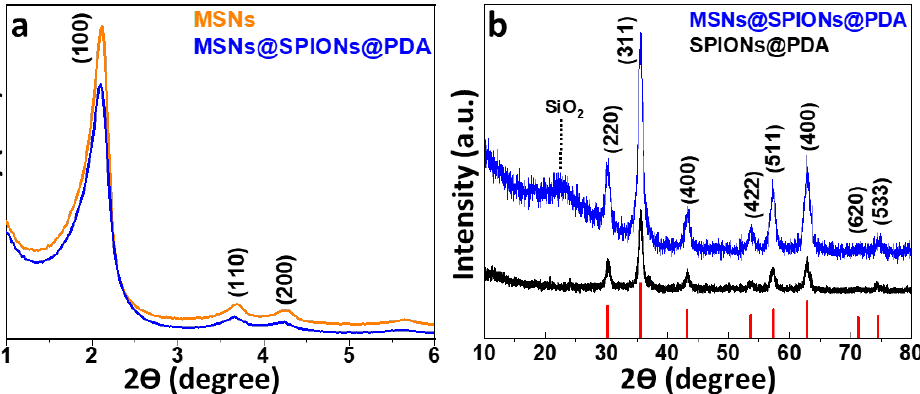
Figure 4. ( a ) Low- and ( b ) wide-angle XRD patterns of MSNs (orange pattern), SPIONs@PDA (black pattern) and MSNs@SPIONs@PDA (blue pattern) compared to the XRD pattern of magnetite from the ICSD card No. 98-015-8742 database.